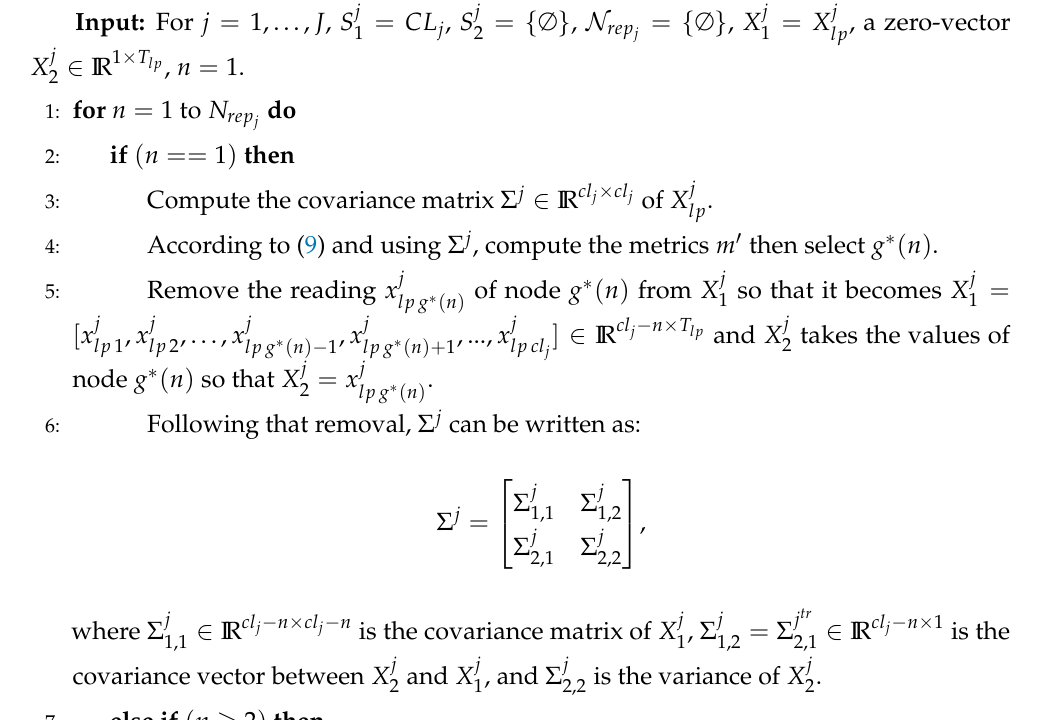
Algorithm 3 A cluster representative sensor nodes selection